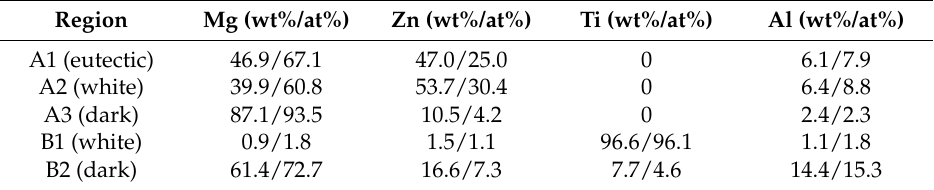
Figure 7. The fractured surfaces of bond made at 5 min. ( A ) Mg side. ( B ) Ti side. Table 1. Corresponding EDS weight/atomic composition for Figure 7.